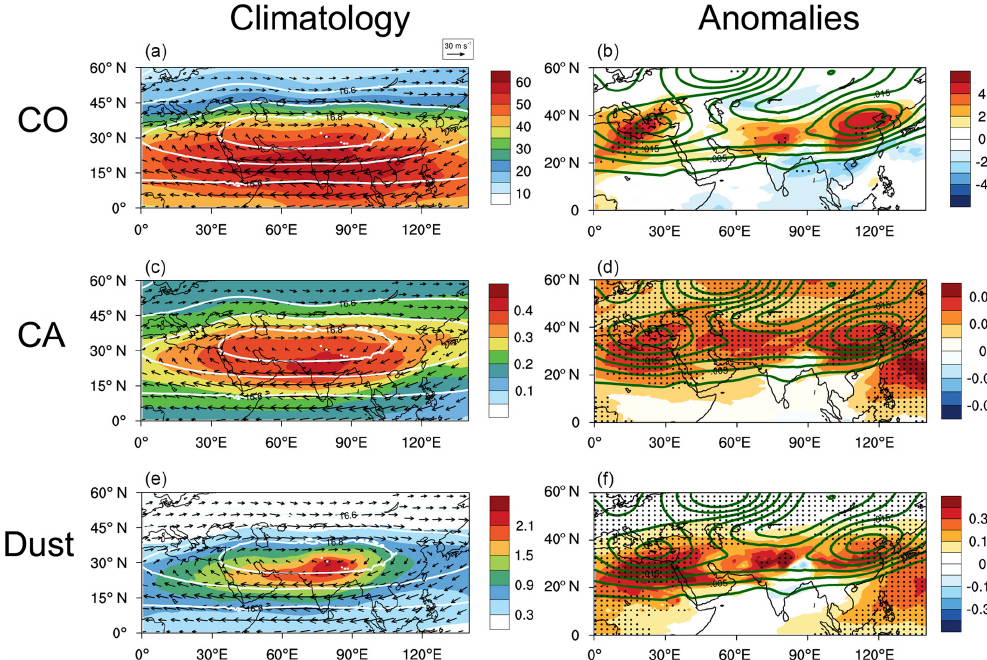
Figure 4. Spatial patterns of chemical gases and aerosol species distributions of (a) CO (ppbv), (c) CA (ppbm) and (e) dust (ppbm) at 108.7hPa during July–August, superimposed with geopotential height anomalies at 100hPa (white contours, in km) and 108.7hPa winds (arrows, in ms − 1 ). Panels (b) , (d) and (f) are the same as (a) , (c) and (e) except that they show anomalous distributions between strong and weak monsoon years (“strong” minus “weak”), superimposed with geopotential height anomalies (green contours) at the same level. Dots represent data points with a significance >95%.